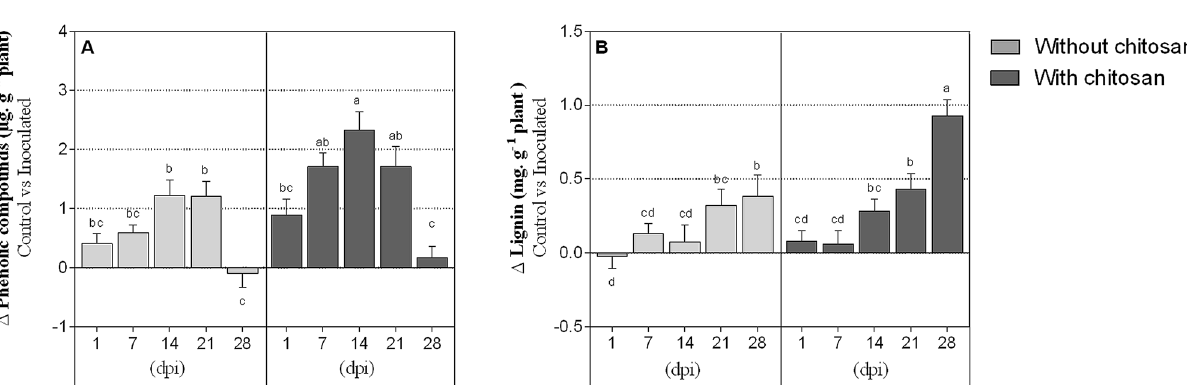
Figure 4. Total phenolic compounds and lignin. Total phenolic compounds and lignin concentrations in P. pinaster stem tissues 1, 7, 14, 21 and 28 days post-inoculation (dpi) with the pinewood nematode (PWN) B. xylophilus . Plants were inoculated 14 days following the application of 0.5% acetic acid (without chitosan, non- elicited controls) or a chitosan solution to plants’ substrate. Data represents the difference between the averages of PWN-inoculated and water-inoculated plants ± SE, and different letters indicate statistically different means at P <